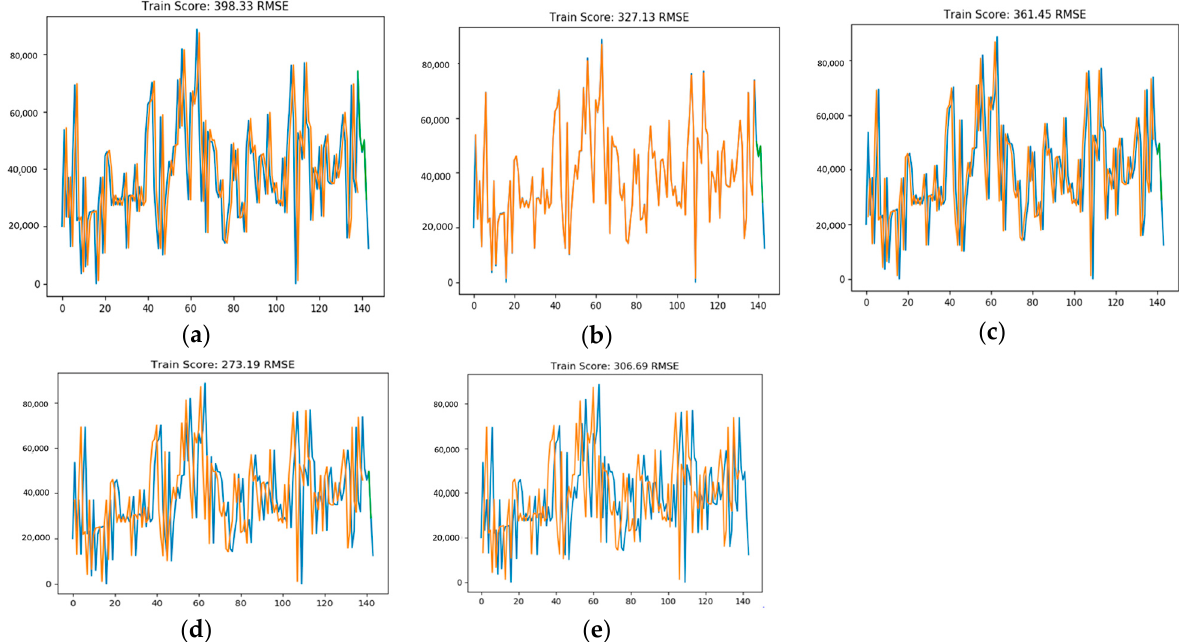
Figure 6. A diagram of a rolling forecast. ( a ) Predicted five values in the test set; ( b ) predicted the second to fifth data of the test set; ( c ) predicted the third to fifth strokes of the test set.; ( d ) predicted the fourth to fifth data of the test set; ( e ) predicted of the fifth demand in the test set.